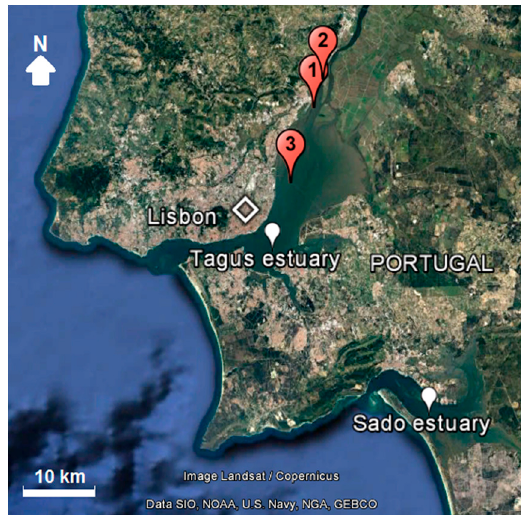
Figure 2. Locations where weakfish Cynoscion regalis (Bloch & Schneider, 1801) (Actinopterygii: Sciaenidae) were collected in the Tagus estuary—Alverca (3 May 2015) (1), Alhandra (16 September 2016) (2), Vasco da Gama bridge (12 November 2016) (3). Map retrieved from Google